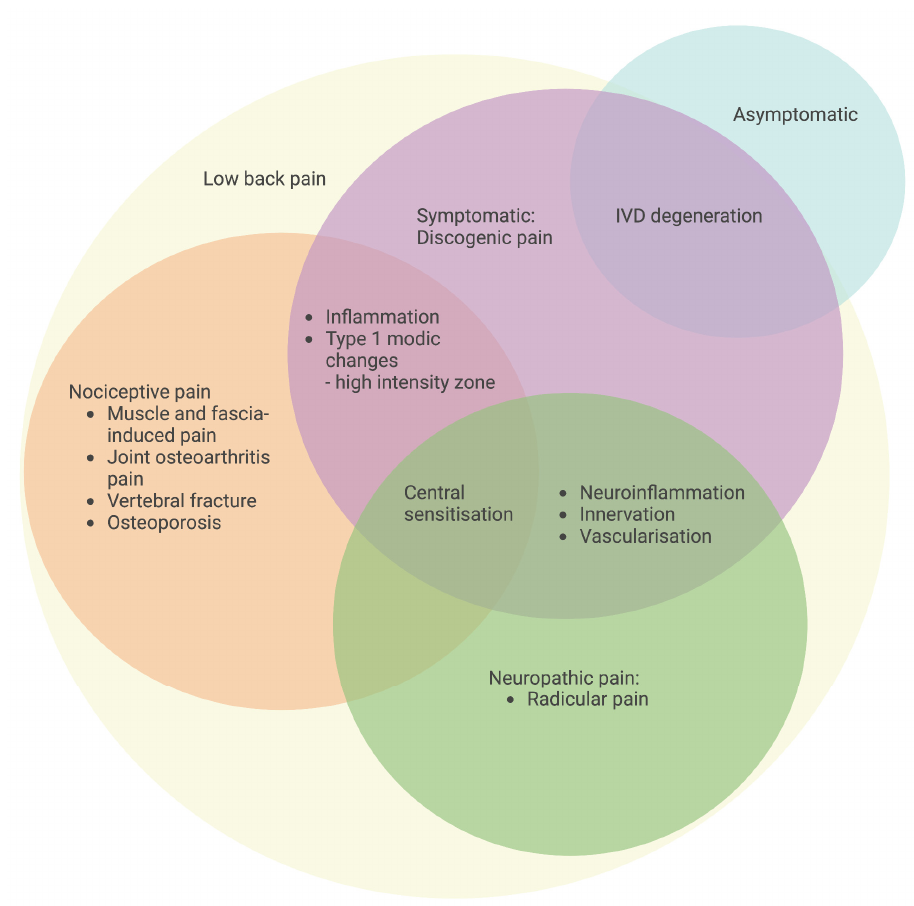
Figure 3. Classification of specific LBP with an emphasis on pain origin. Symptomatic IVD degeneration with discogenic LBP is characterized by inflammation, a high-intensity zone, neuroinflammation-induced innervation and vascularization, and central sensitization for the development of pain. The schematic was created with BioRender.com.